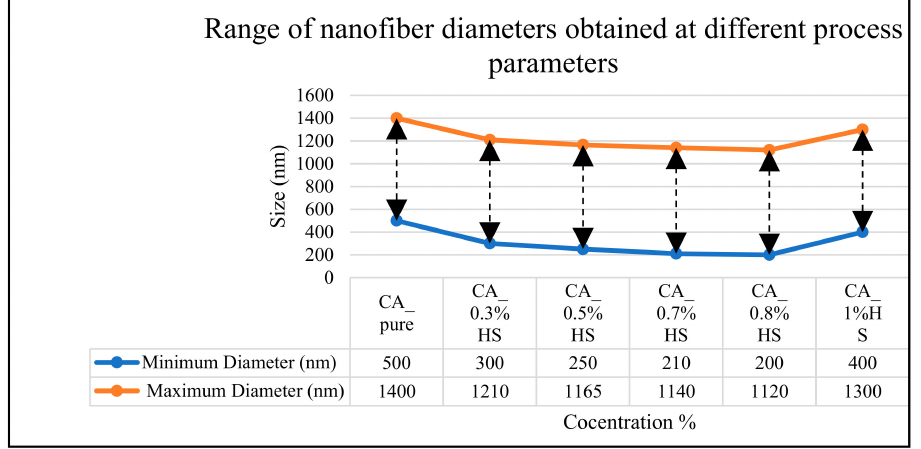
Figure 10. Range of nanofiber diameters produced from pure CA and CA + HS at different pro- cess